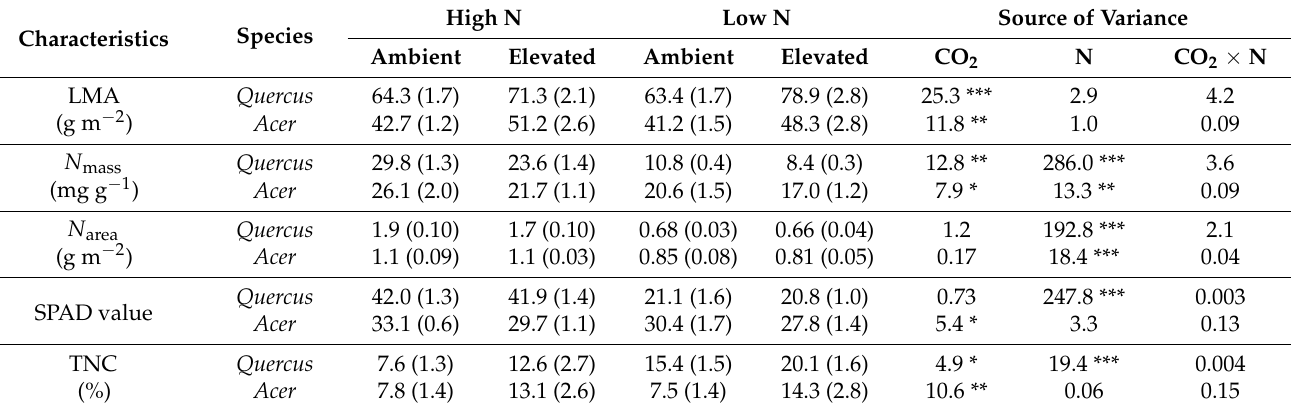
Table 1. Leaf mass per area (LMA), mass-based leaf N ( N mass ), area-based leaf N ( N area ), soil plant analysis development (SPAD) values, and total nonstructural carbohydrate (TNC; sum of soluble sugar and starch) according to CO 2 and N treatments in Quercus mongolica ( Quercus ; 1.5-month-old leaves) and Acer mono ( Acer ; 1-month-old leaves). Mean values (standard error) for each treatment are shown ( n = 5–9). Results of ANOVA ( F -value) for CO 2 treatments (ambient: ambient CO 2 ; elevated: elevated CO 2 ) and N treatments (high N, low N) are shown. * p < 0.05; ** p < 0.01; *** p < 0.001. High N Low N Source of Variance Characteristics Species Ambient Elevated Ambient Elevated CO 2 N CO 2 × N